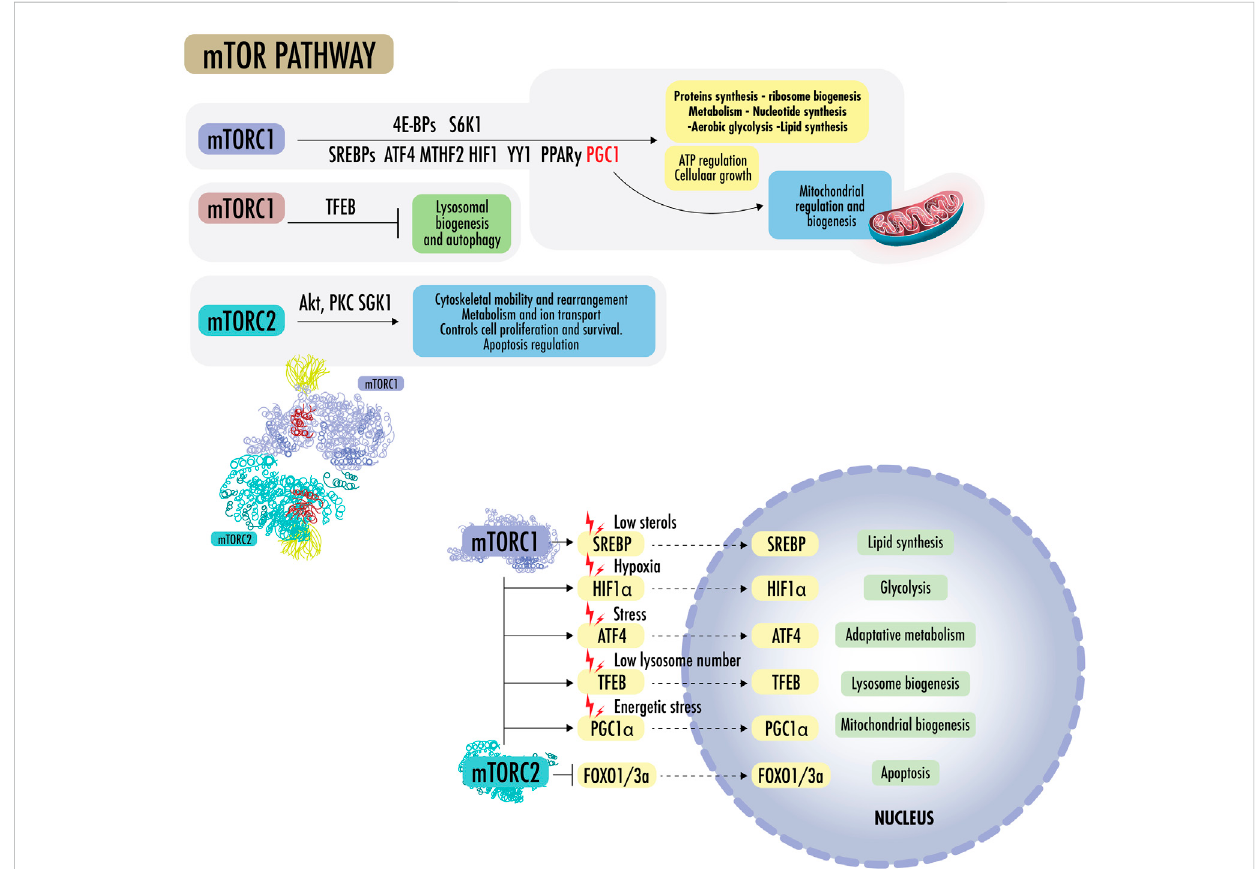
FIGURE 3 mTOR pathway: mTORC1 promotes protein synthesis by phosphorylating eukaryotic initiation factor 4E-binding proteins (4E-BPs) and p70 S6 kinase 1 (S6K1), increasing the production of ATP, nucleotides, and lipids. The lipid synthesis occurs primarily through the sterol regulatory element, protein-binding protein ½(SREBP1/2),and peroxisome proliferator-activatedreceptor- γ (PPAR γ ).In theabsence of sterols, SREBPs translocate to the nucleus to regulate genes for de novo cholesterol and other lipid synthesis. mTOR1 regulates the supply of one-carbon units for the biosynthesis of nucleotides for DNA/RNA replication, as it regulates methylenetetrahydrofolate dehydrogenase 2 (MTHFD2), the mitochondrial tetrahydrofolate cycle enzyme, carbamoyl-phosphate synthetase 2 (CPS2), aspartate transcarboxylase (ATCase), dihydroorotase (CAD), and the rate- limiting enzyme in pyrimidine biosynthesis, among others. mTORC1 regulates the transcription factor hypoxia-inducible factor 1 α (HIF1 α ), which increases the expression of glycolytic enzymes and favors glycolysis over OXPHOS. mTORC1 activates mitochondrial transcripts through 4E-BP1 and stimulates mitochondrial biogenesis by driving PGC1 α . mTORC1 can simultaneously activate SREBPs, transcription factor ATF4, HIF1, Yin Yang 1 (YY1), PPARy, and PGC1a to drive mitochondrial regulation, ATP regulation, macromolecules synthesis, and cellular growth, blocking lysosomal biogenesis through transcription factor EB (TFEB). mTORC2 effectors include protein kinase B (Akt/PKB) and protein kinase C alpha (PKC α ), a member of the AGC familyofproteinkinases(PKA/PKG/PKC).mTOR2playsaroleincytoskeletalrearrangement,actinregulation, chemotaxis,